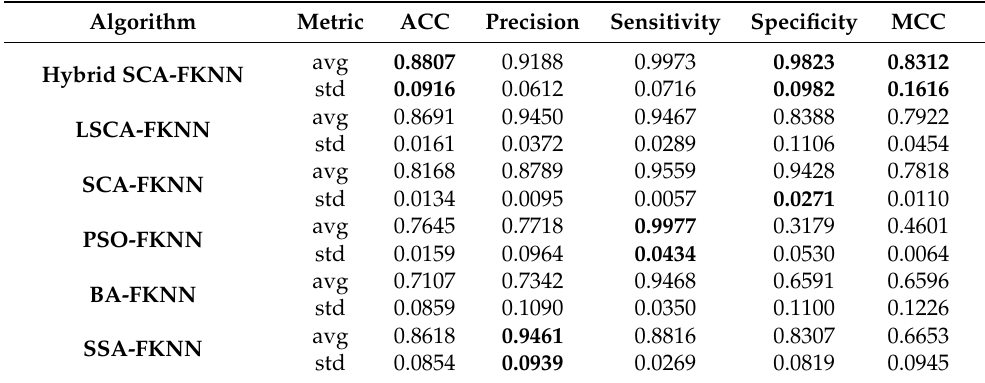
Table 13. Resultsof the hybrid-FKNN and comparison models on the car dataset. (Bold indicates the best in comparison method).